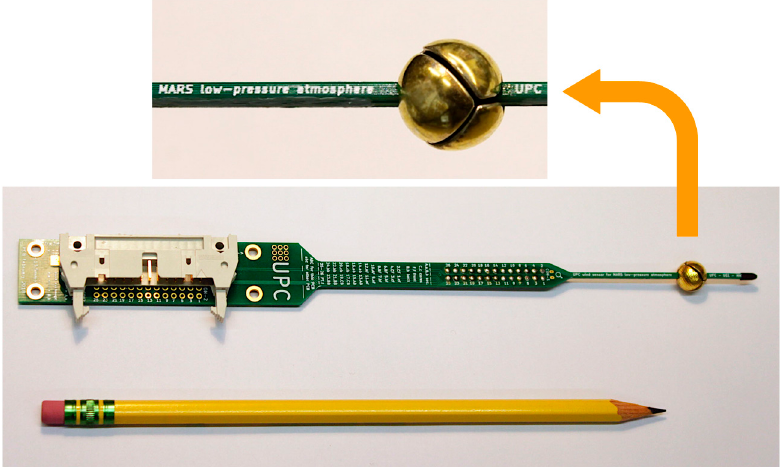
Figure 3. Bottom: Photograph of the sensor with its printed circuit boards (PCB) support structure. Top: Detail of the 10 mm spherical head, showing the shape of the sectors.